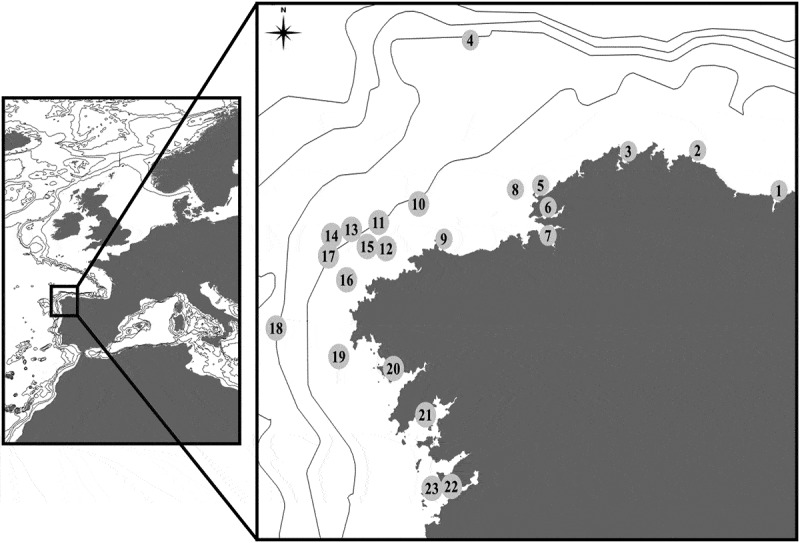
Sampling localities in Galician waters. See also Table 1.